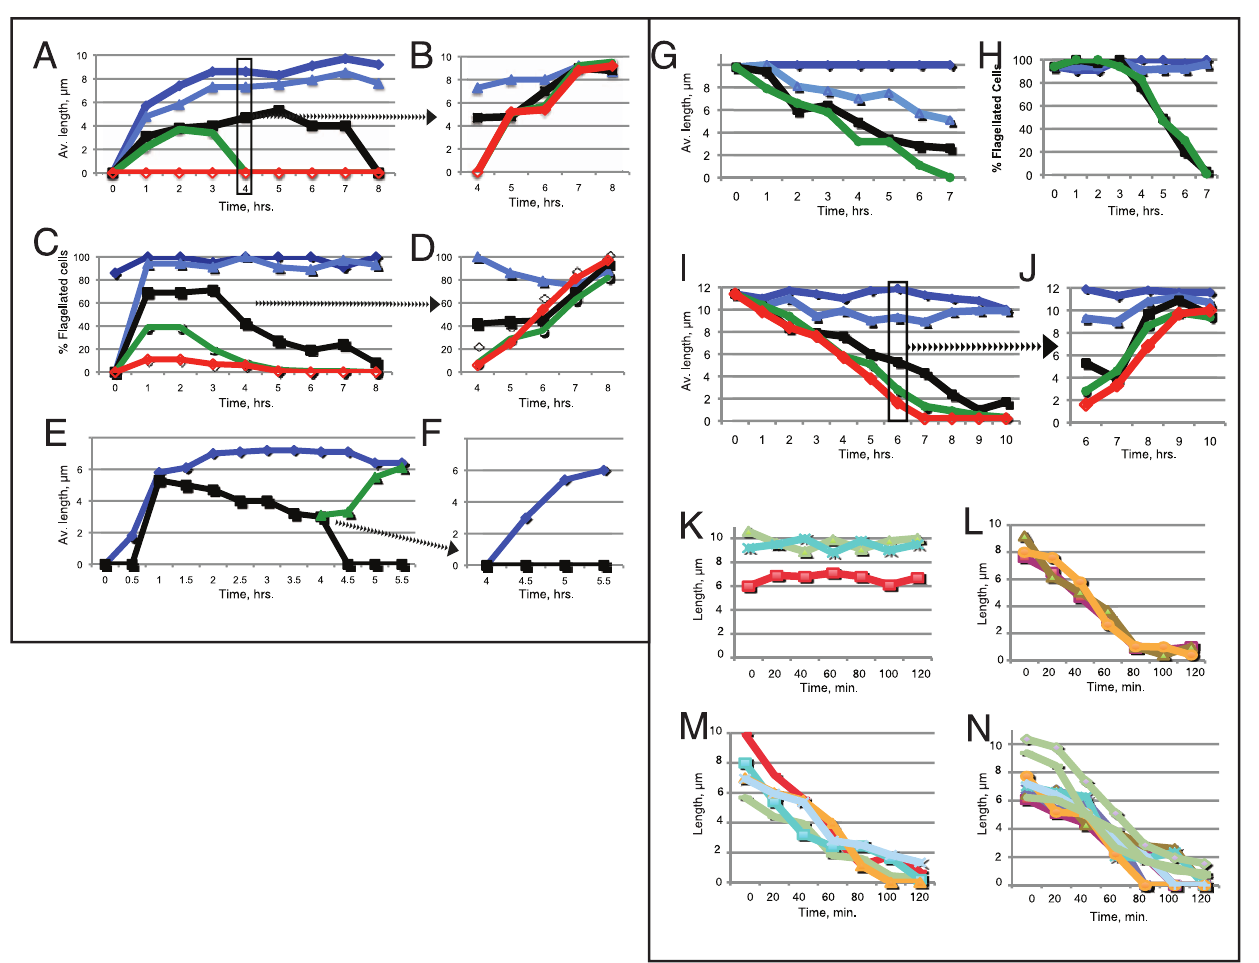
Figure 1. BFA reversibly inhibited flagellar regeneration (A–F) and induced fully grown flagella to disassemble (G–N). A–D: Flagellar lengths on WT cells regenerating with 0 (diamonds), 3.6 m M (triangles), 18 m M (squares), 36 m M (circles), or 54 m M BFA (open diamonds). A: Four hrs after deflagellation, a portion of cells was washed suspended without BFA (B). C–D: percentage of flagellated cells. E, F: Regeneration of deflagellated pf16 without (diamonds) or with (squares) 18 m M BFA. Flagella regrew to control lengths upon BFA removal (triangles). F: Cells regenerated in BFA for 4 hrs (E) were re-deflagellated and incubated without (diamonds) or with (squares) 18 m M BFA. G, H: Flagellar lengths (G) and percentage of flagellated cells (H) when WT cells were treated with 0–36 m M BFA. I: Flagellar lengths on WT cells treated with 0 m M (diamond), 3.6 m M (triangles), 18 m M (squares), 36 m M (dots), 54 m M (open triangles). BFA. J: Flagellar on cells washed free of BFA at 6 hr (I, box). K–N: To determine if BFA induced cells to deflagellate, individual pf16 cells were recorded at 1 min intervals without (K) or with 18 m M (L), 36 m M (M), or 54 m M BFA (N). Each curve represents the length of flagella on an individual cell. Videos of representative cells are shown in Supplementary movies S1, S2, S3, S4. doi:10.1371/journal.pone.0053366.g001 557 Da biotinylation reagent could penetrate the cell wall and were enriched (Fig. 2A ‘‘ + ’’) and some reduced (Fig. 2A ‘‘ 2 ’’) in label plasma membrane proteins. Flagellated cells were biotiny- the vesicle fraction. Coomassie blue and silver stained flagellar lated, washed, deflagellated, and biotinylated proteins were vesicle proteins differ from the axonemes, confirming that vesicles purified from purified flagella and deflagellated cell bodies by fraction is not contaminated by flagella. Another concern was that streptavidin affinity-chromatography. The major biotinylated the vesicle fraction was contaminated with cell debris. To assay for flagellar proteins were purified from flagella (Fig. 2C Biotin Flag) cells or debris, western blots of cells that had not been treated with and numerous biotinylated proteins were purified from the cell the biotinylation reagent were stained with AP-streptavidin to bodies (Fig. 2C Biotin Cell). The major flagellar glycoprotein, reveal endogenously biotinylated polypeptides, presumably car- FMG-1B [53], was identified in both flagellar and cell body boxylases [48], protein ligases [49], amidolyases [50] and possible fractions using an antibody to FMG-1B (Fig. 2C FMG-1B), which confirmed that the reagent was freely accessible to plasma membrane surface-exposed proteins. If flagellar shortening is partially due to the BFA-mediated inhibition of membrane resupply via the secretory pathway, the amount of membrane shed during a 5–6 hr period should be a substantial proportion of the flagellum. To estimate of the quantity